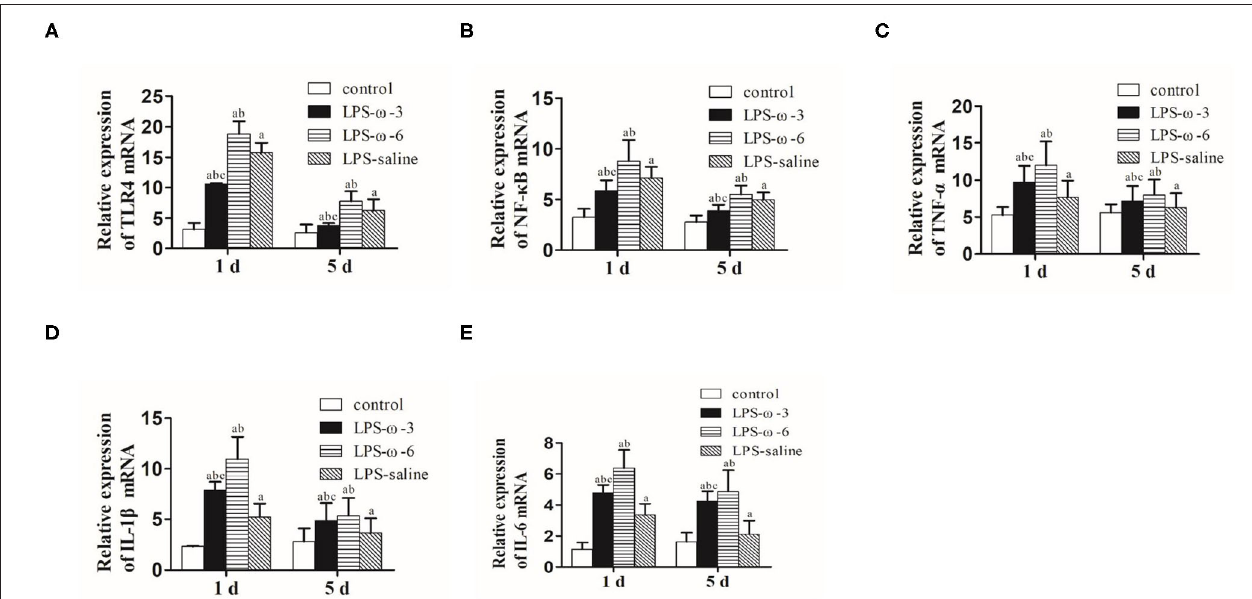
FIGURE 1 | mRNA expression of inflammation-related genes. PCR was performed to determine the mRNA expression of TLR4 (A) , NF- κ B (B) , TNF- α (C) , IL-1 β (D) , and IL-6 (E) in the hippocampus of neonatal rats. Data are expressed as mean ± standard deviation (SD). a P < 0.05 vs. the control group, b P < 0.05 vs. the LPS group, c P < 0.05 vs. the ω -6 group; n = 12. LPS, lipopolysaccharide; NF- κ B, nuclear factor kappa B; TNF- α , tumor necrosis factor- α ; IL-1 β , interleukin-1 β ; IL-6,